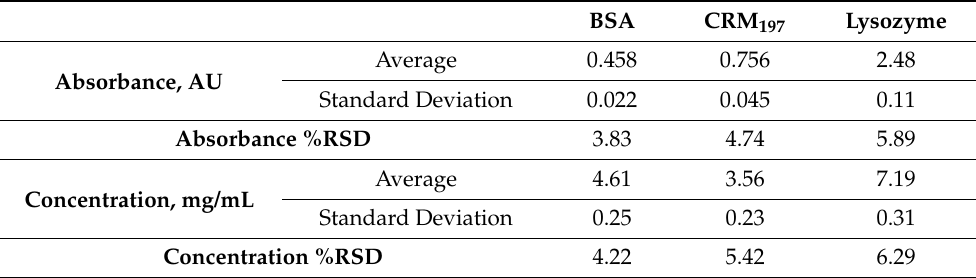
Table 2. Average value, standard deviation and %RSD for the proteins when analyzed with UV-Vis spectrophotometer in adsorption conditions (1 mol/L ammonium